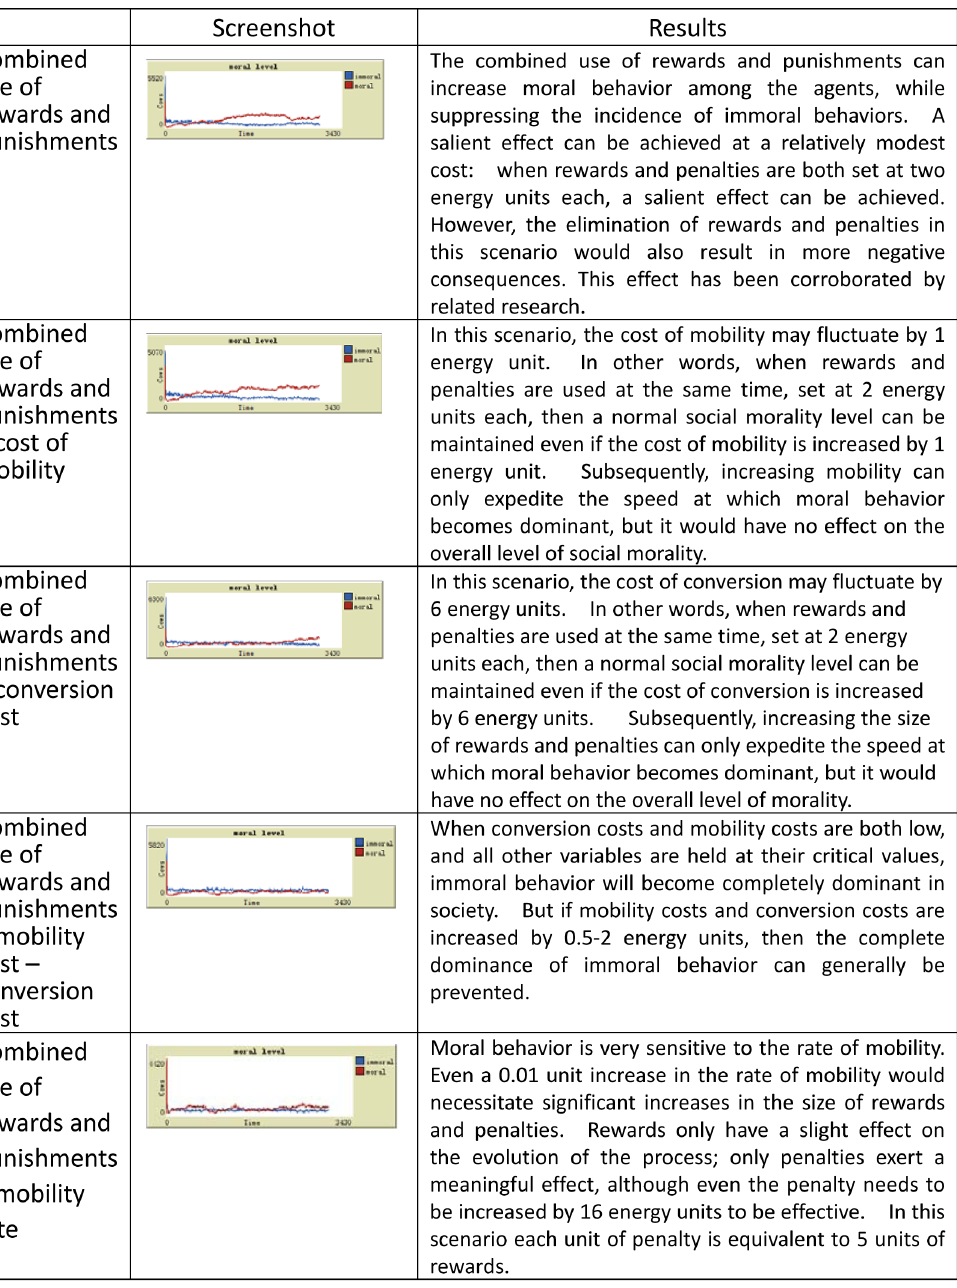
Figure 4. Simulation results with multivariate controls. In this type of analysis, we can seek to observe changes in the overall level of social morality while modifying two or more variables simultaneously.